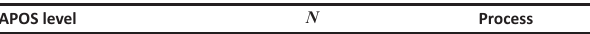
TABLE 6: Frequency of students’ responses for task 1b (iii) according to APOS level.